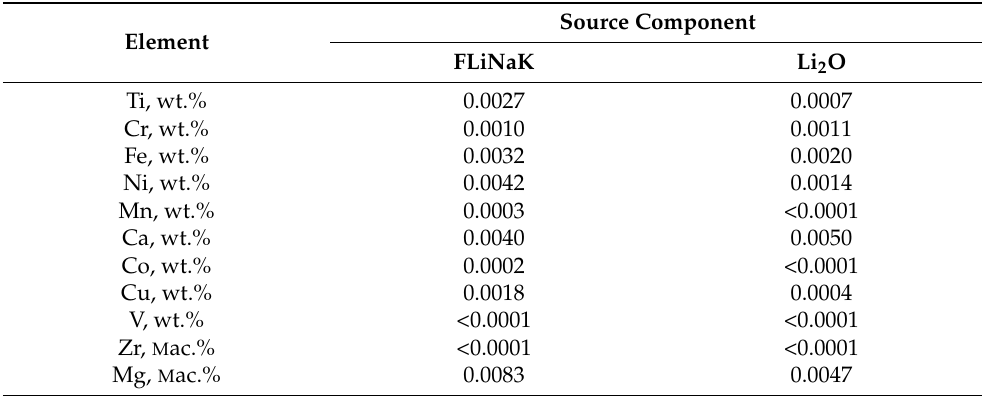
Table 1. Elemental composition of the initial FLiNaK and Li 2 O.